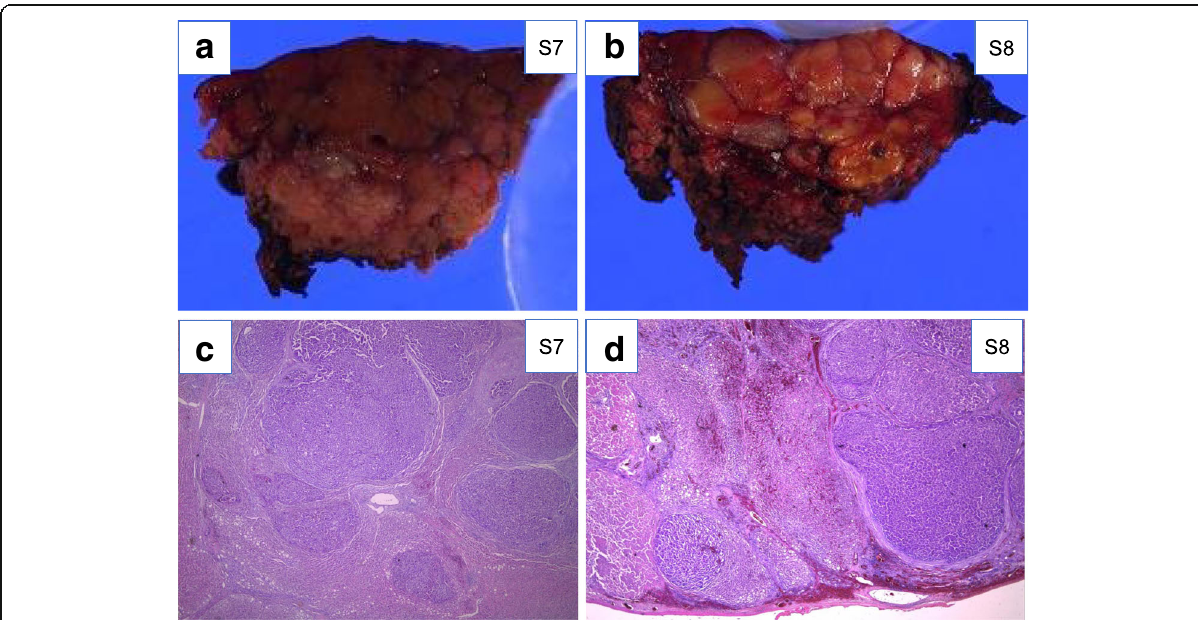
Fig. 5 Macroscopic findings and histological examination of the resected specimen of segments 7 and 8. a The specimen of S7 demonstrates confluent multinodular type, 14 mm in diameter. The weight of the specimen was 10 g. b The specimen of S8 demonstrates confluent multinodular type, 4.5 mm in diameter. The weight of the specimen was 15 g. c The lesion of S7 demonstrates moderately differentiated hepatocellular carcinoma (H&E staining ×20). d The lesion of S8 demonstrates poorly differentiated hepatocellular carcinoma (H&E staining